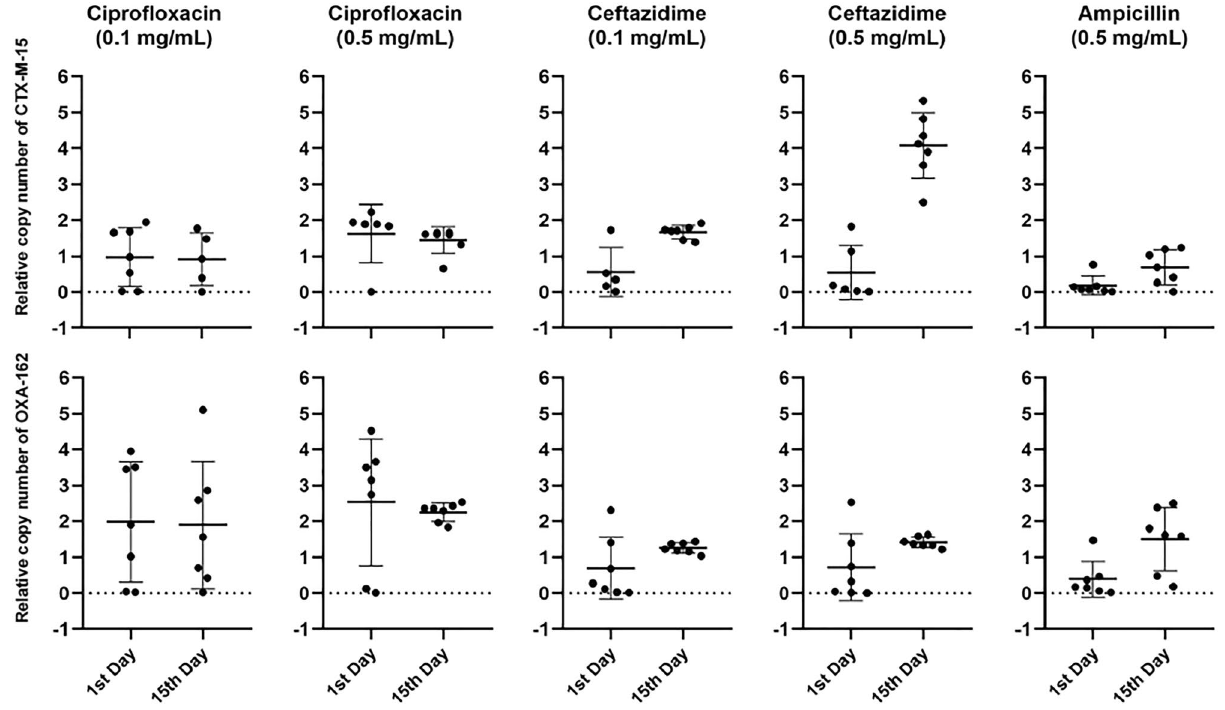
Figure 3. The relative copy number of the bla CTX-M-15 and bla OXA-162 genes from the feces of individual mice after the different antibiotic-treatment regiments on the first and fifteenth days after colonization with